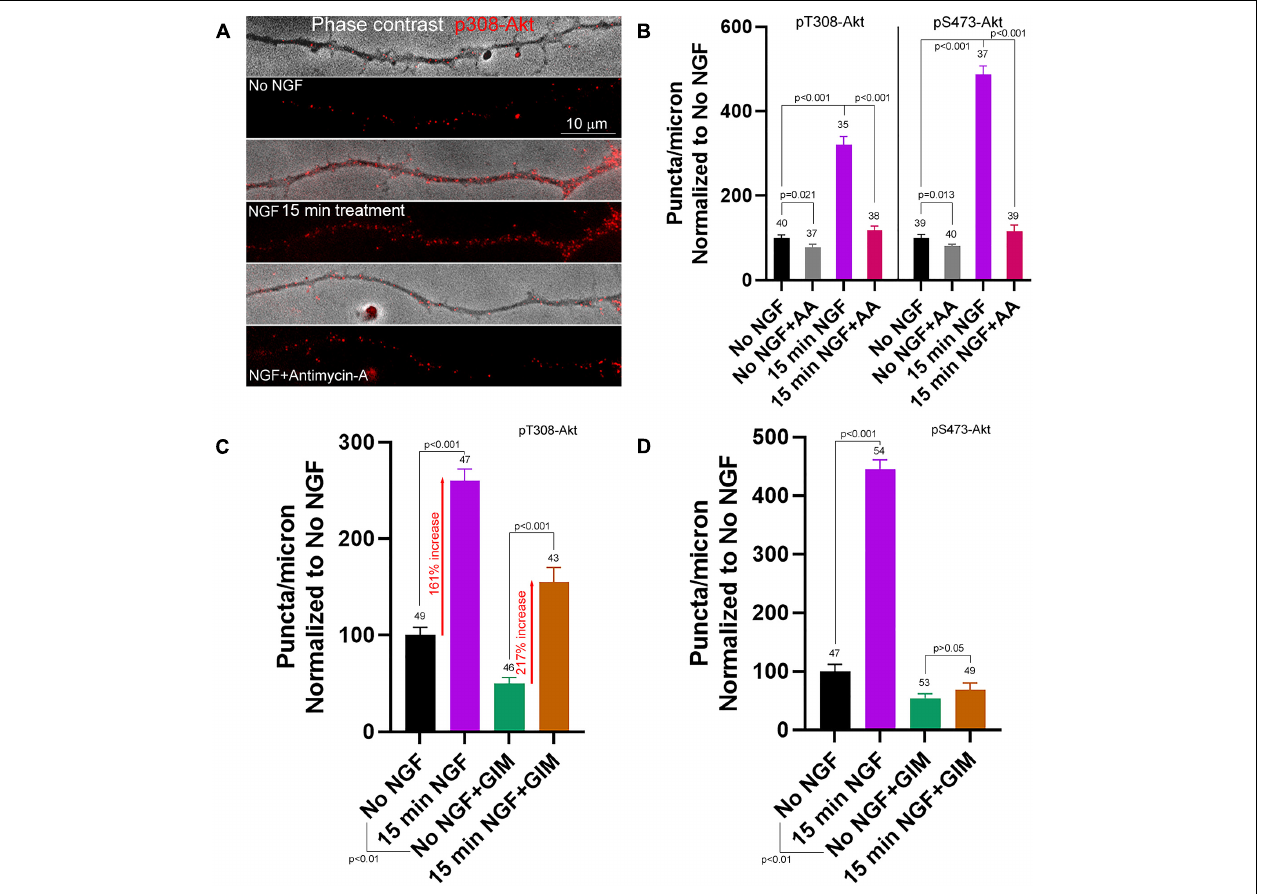
FIGURE 4 | Contributions of oxidative phosphorylation and glycolysis to the early phase of NGF driven pT308-Akt and pS473-Akt phosphorylation. (A) Examples of pT308-Akt staining in axons (shown in overlay with phase contrast images) with 15 min treatments of no NGF, NGF or NGF with antimycin-A (AA). (B) Quantification of the density of pT308-Akt and pS473-Akt puncta following treatment with AA under no NGF and NGF 15 min treatment conditions. (C) Effects of inhibition of glycolysis using glycolysis inhibition medium (GIM) or control medium exchange on the density pT308-Akt puncta. GIM decreased the baseline density of pT308-Akt puncta in the absence of NGF, but NGF treatment elevated the density to a similar fold increase with both GIM and control medium (percent increase relative to the corresponding baseline is denoted). (D) GIM treatment alone decreased the baseline density of pS473-Akt puncta in no NGF treatment conditions and blocked the NGF induced increase in the density of pS473-Akt